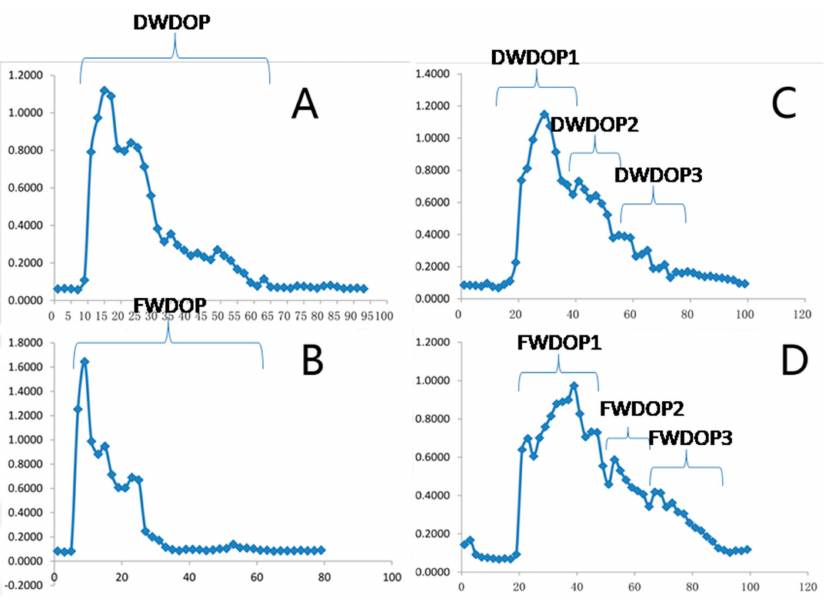
Figure 1. The ( A , B ) DEAE and ( C , D ) Sephadex G-25 elution graphs of DWDOP and